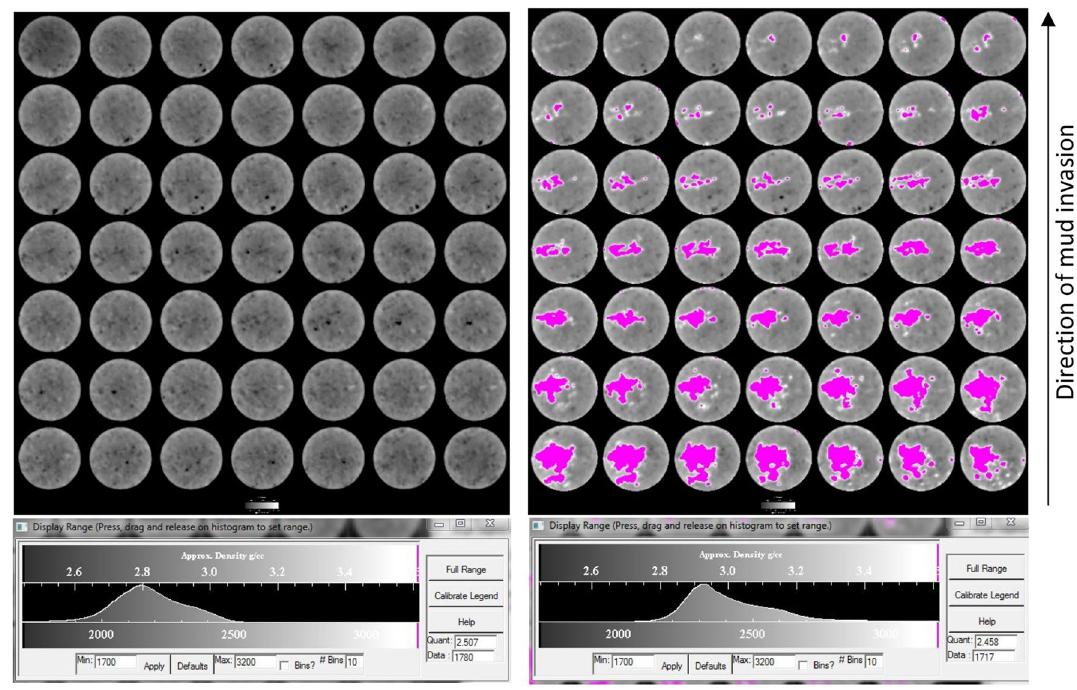
Fig. 5 CT scan of sample 1 showing: (left) pre-filtration-loss slices and (right) post-filtration-loss